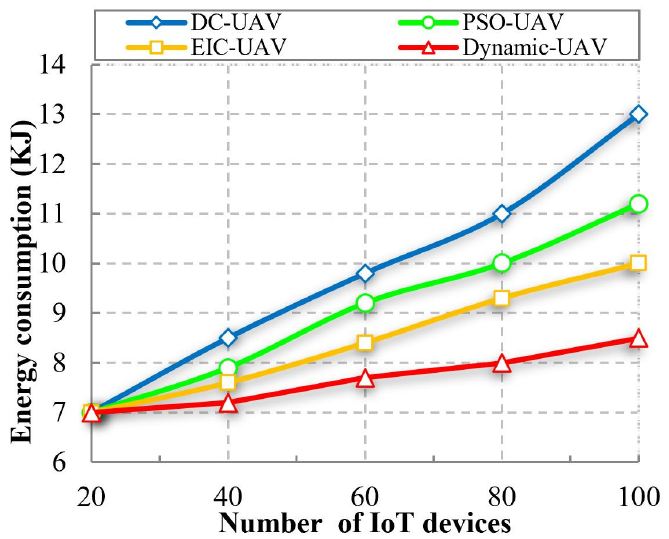
Figure 15. Energy consumption to the Number of IoT devices.